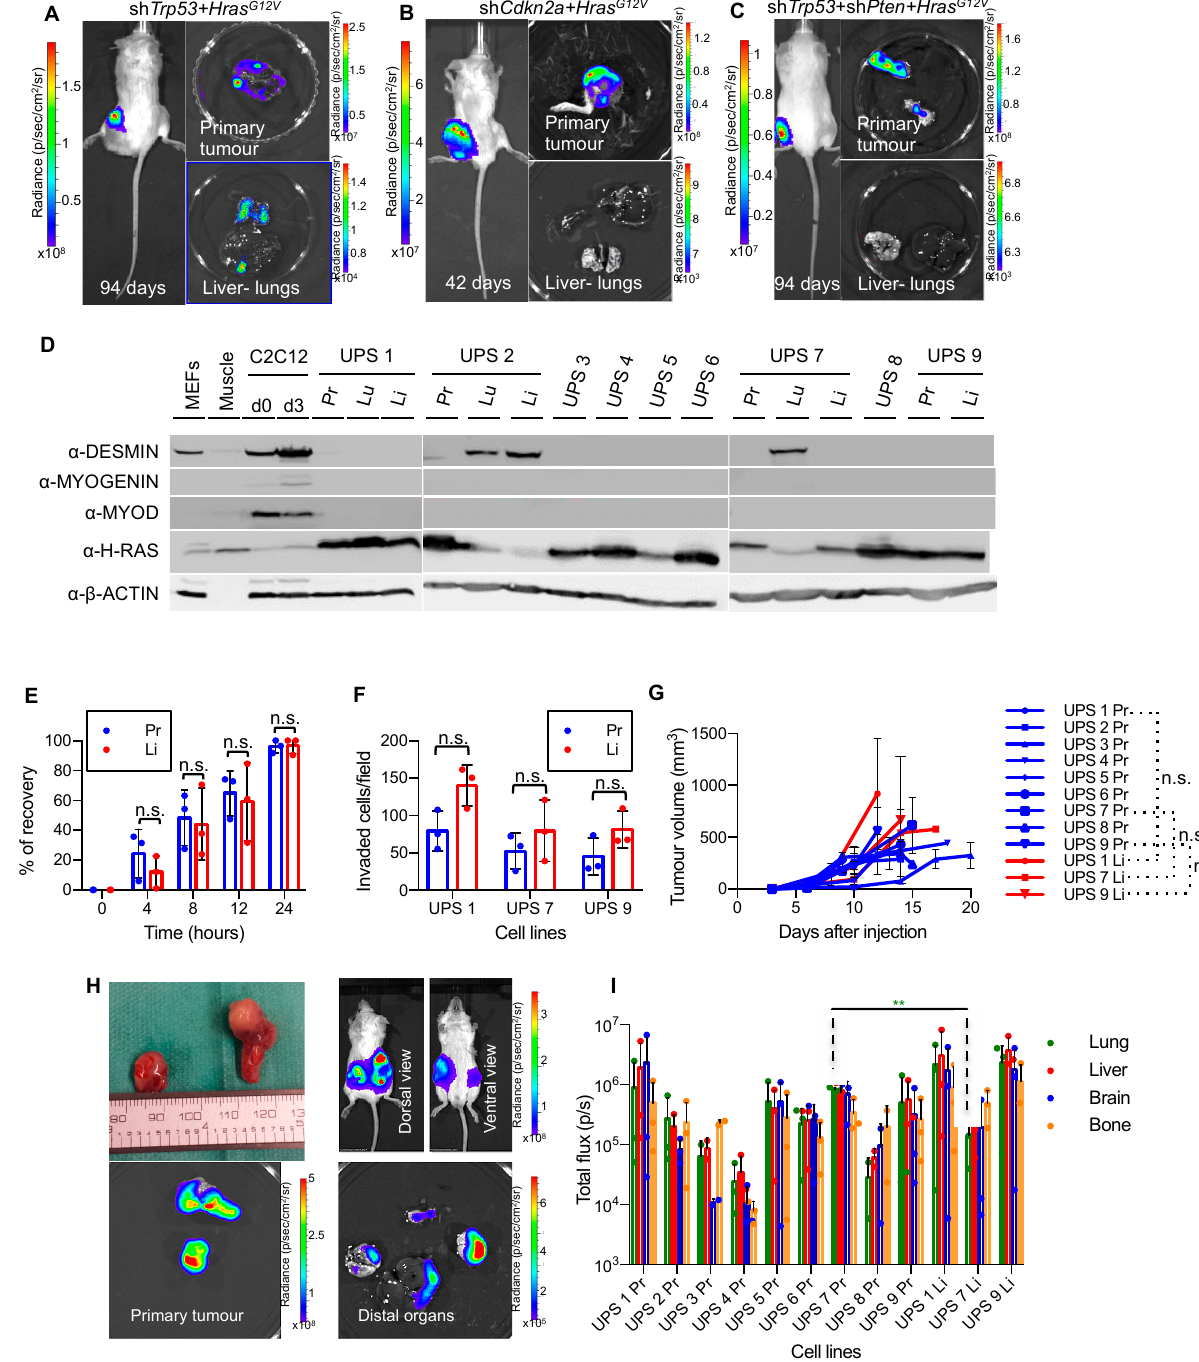
Figure 1. Establishing an Hras G12V -driven autochthonous metastatic UPS model. ( A – C ) . Representative bioluminescence imaging of living mice and of primary tumors, lungs and livers of tumor-bearing SCID/Beige mice induced by intramuscular injection of MuLE viruses expressing luciferase plus either shRNA- Trp53 + Hras G12V ( A ) shRNA- Cdkn2a + Hras G12V ( B ) or shRNA- Trp53 + shRNA- Pten + Hras G12V ( C ). ( D ). Protein immunoblotting for the indicated antibodies on cells isolated from primary UPS tumors (Pr) and metastatic lesions from lungs (Lu) and livers (Li), as well as on mouse embryo fibroblasts (MEFs), mouse muscle and C2C12 myoblast cells at day 0 and day 3 of myogenic differentiation as controls. VINCULIN is used as loading control. ( E ). Time course of recovery of wounds induced by scratch assay on confluent cells. Experiments were performed on UPS 7 Pr and UPS 7 Li. Results are representative of similar experiments performed using UPS 1 Pr and UPS 1 Li and using UPS 9 Pr and UPS 9 Li (Figure S2). Mean ± std. dev. are shown ( n = 3). In all matching pairs of cells, the differences between primary tumor and metastatic cell lines were not statistically significant ( p > 0.05, unpaired t-test Holm-Sidak method). ( F ). Overnight trans- well migration assay. Data is derived from analyses of ten independent fields of 1.5 mm 2 per membrane and is depicted as